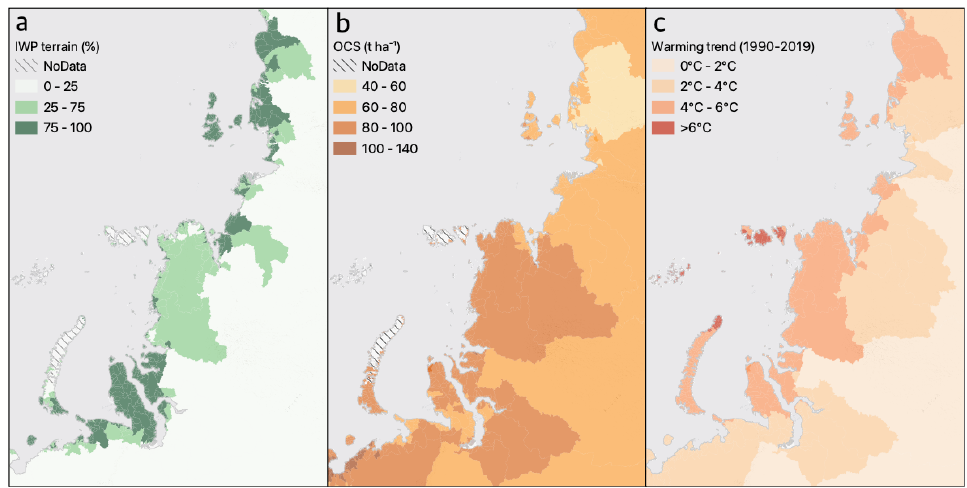
Figure 3. Siberian coastal watersheds with ice wedge polygon (IWP) terrain (% watershed coverage) (a) , soil organic carbon stock (OCS) in metric tonnes per hectare (b) , and the mean watershed temperature trend taken over the period 1990–2019 (c) (map source: ARCADE database (Speetjens et al.,